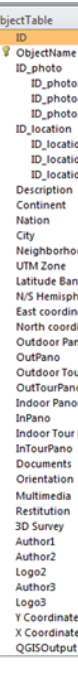
Figure 5. The Object Table items ( fields